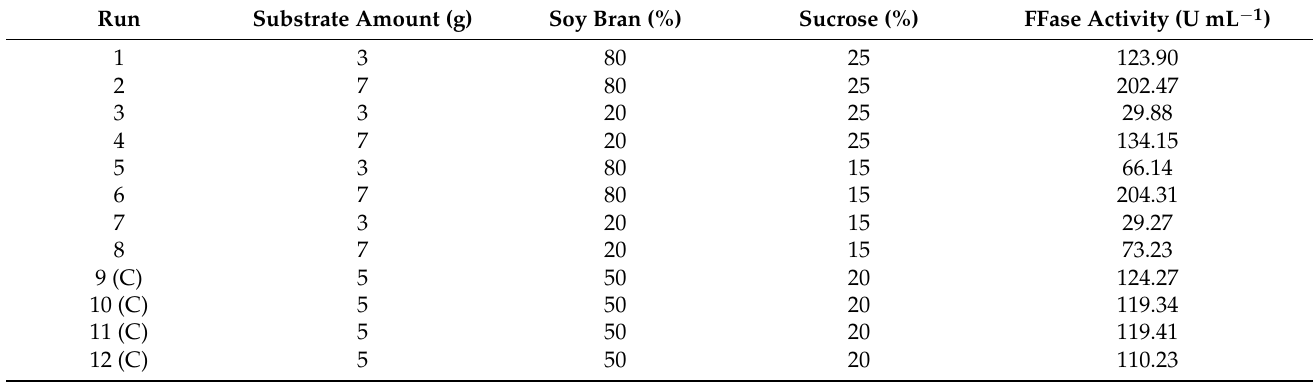
Table 1. Experimental conditions and results of 2 3 full factorial design used for evaluation of the production of FFase by A. tamarii Kita UCP1279, using a mixture of wheat and soy bran as substrate through solid-state cultivation.